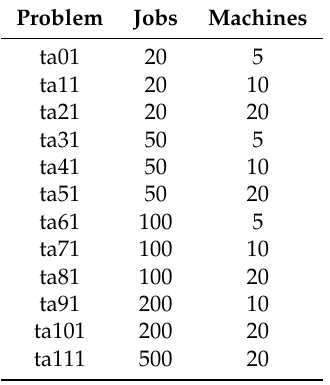
Table 3. Taillard [50] benchmarks for the permutation flow shop scheduling problem (PFSP).